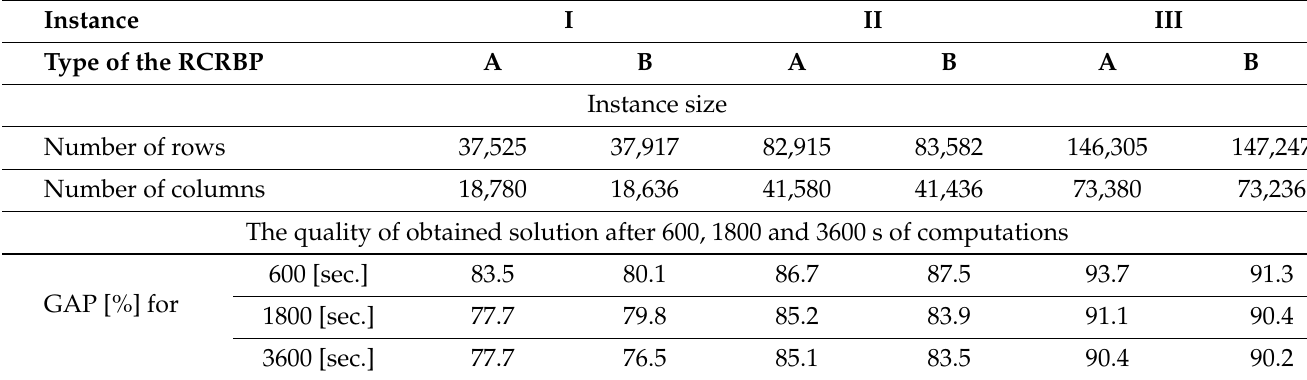
Table 4. Summarization of the results of computational